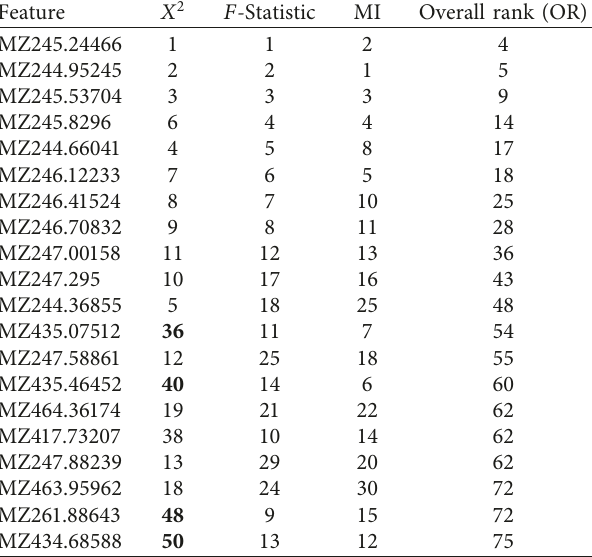
Table 6: Overall rank table (ORT) for the leukemia dataset. Features are arranged from the most important, at the top, to the least important at the bottom according to their assigned overall rank (OR), which is calculated after moderating the outliers (shown in bold) as per Algorithm 1. The smaller the overall rank, the more significant the feature.